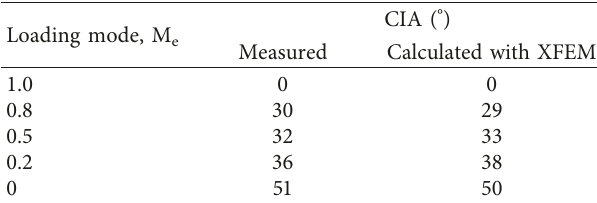
Table 6: The CIA at different loading